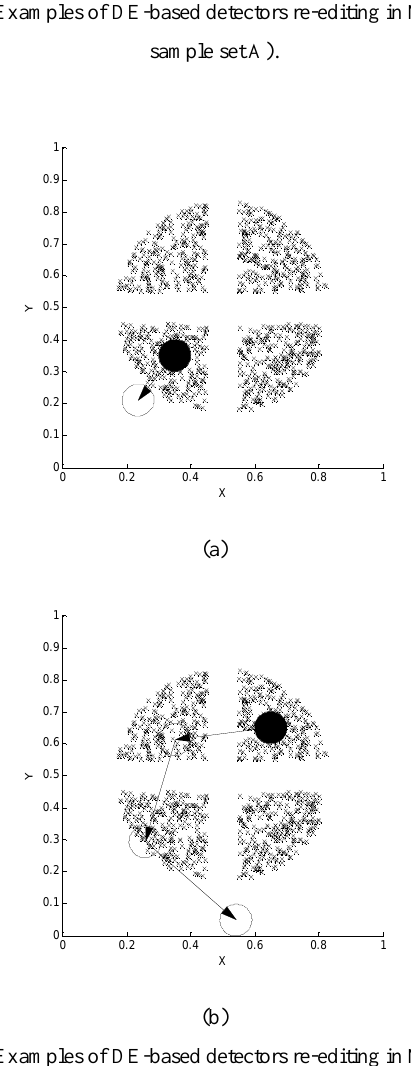
Fig. 5. Examples of DE-based detectors re-editing in NSA (self sample set